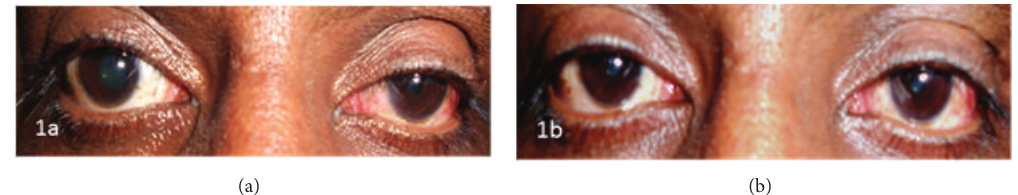
Figure 1: (a) Right sided irregularly dilated pupil with minimal reaction to light suggestive of tonic pupil and a normally reacting left pupil. (b) Right pupil shows constriction (denervation supersensitivity) and no constriction in left pupil with 0.125% pilocarpine.